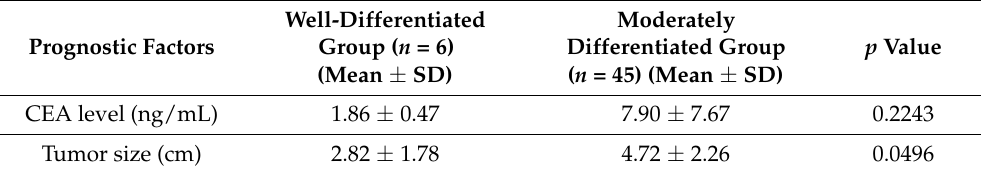
Table 4. Comparison of prognostic factors according to tumor